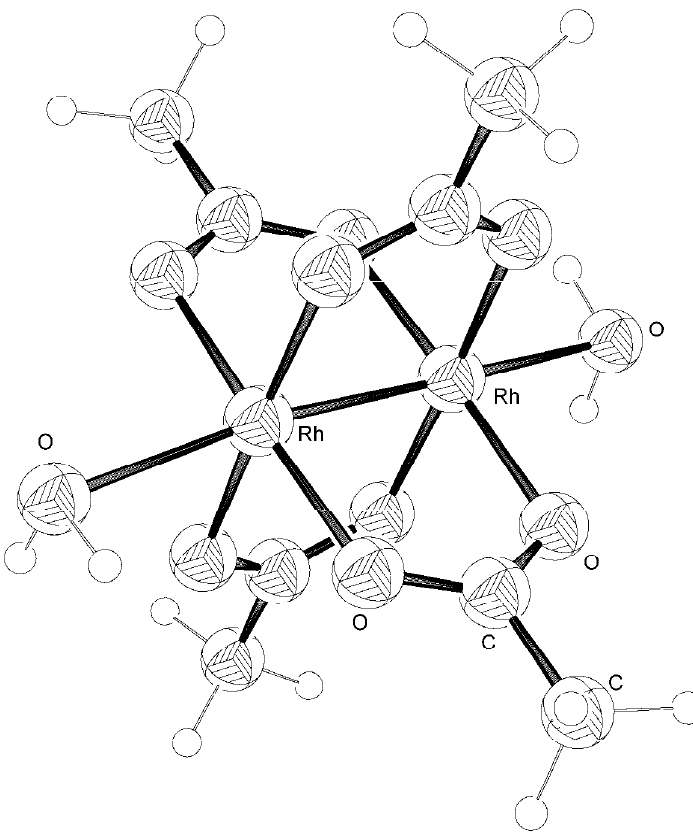
Figure 1. The structure of diaquo rhodium acetate; representative atoms have been